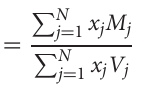
by crystallization of a gabbroic assemblage with a modal mineralogy of ∼ 10% olivine, ∼ 40% clinopyroxene and ∼ 50%